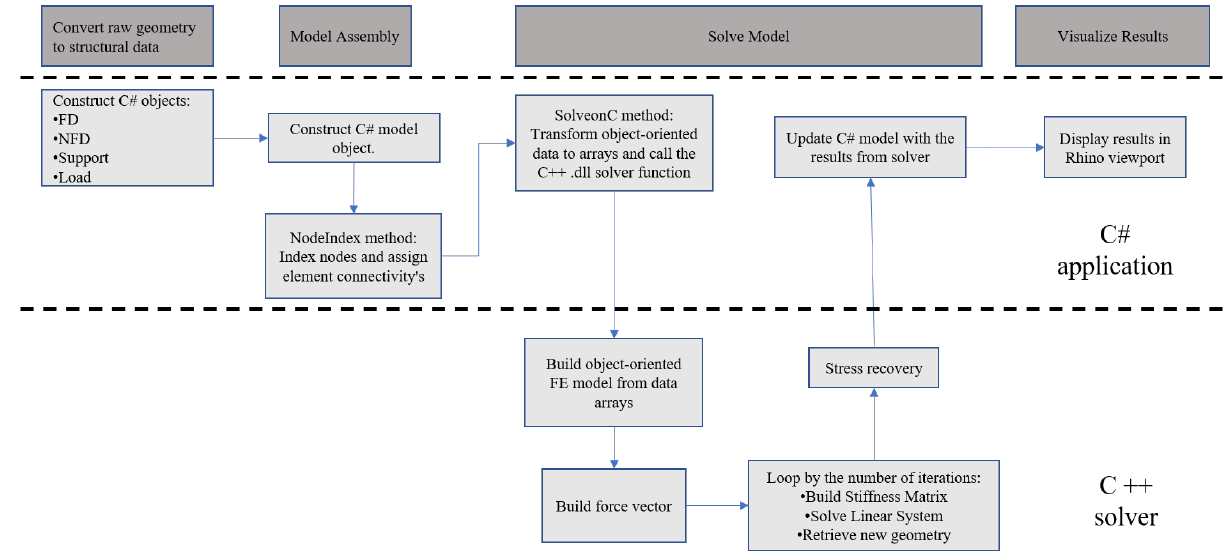
Figure 7: Workflow of the application and solver